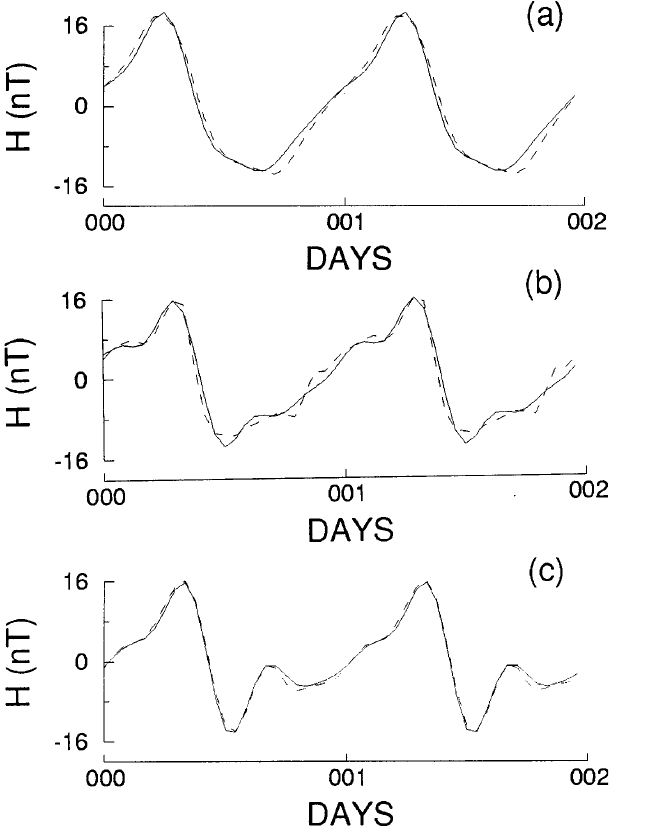
Fig. 3a–c. A comparison of the daily variations determined by HA ( solid curves ) and ANN ( dashed curves ) methods. Three ANNs were trained using H-component data from HER for separate one month periods during 1993. The ANNs were then each used to estimate the daily variations for two-day intervals in the middle of the same months, namely a January, b April, and c July Table 2. RMS errors between observed H-component daily variation curves at HER and those determined by the HA and ANN methods respectively for three separate one month periods in 1993